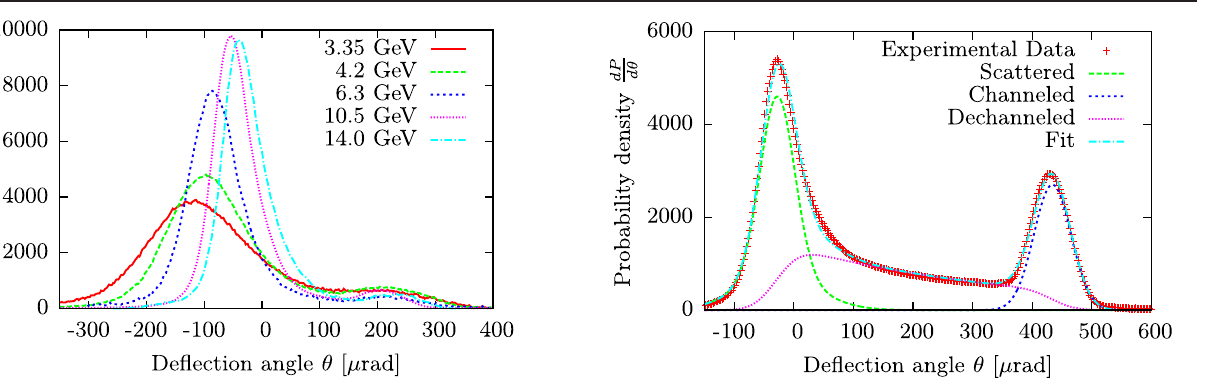
FIG. 10. A fit to the 10.5 GeV experimental data in the channeling orientation.